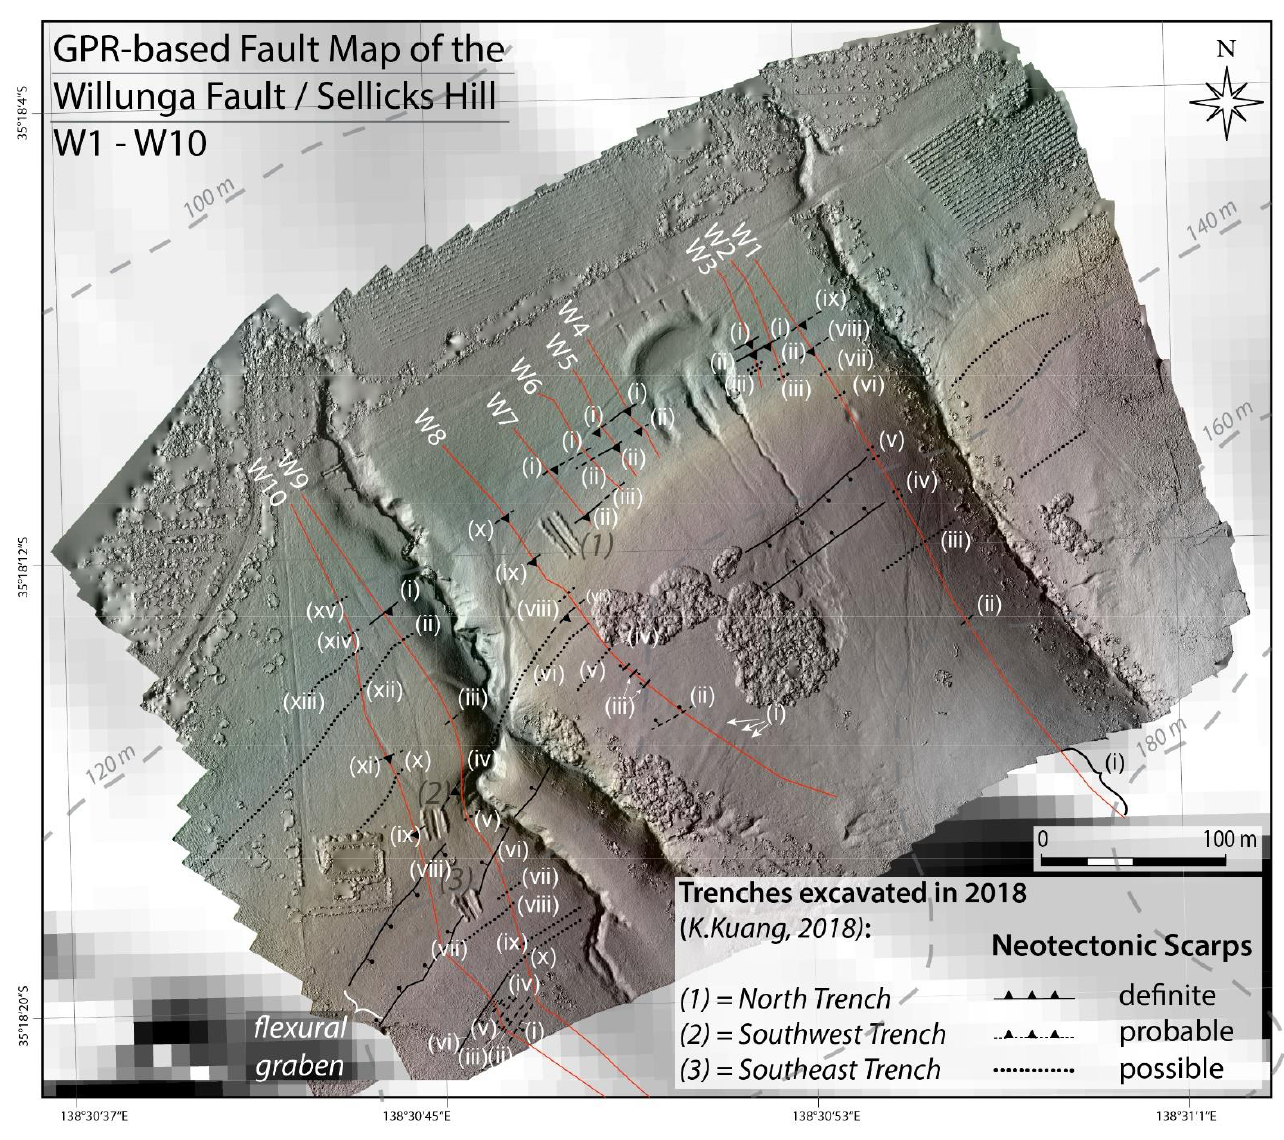
Figure 3. Map of fault traces at the Willunga Fault field site as interpreted from each GPR transect. White roman numbers indicate each feature identified in the GPR data and are explained in the text.